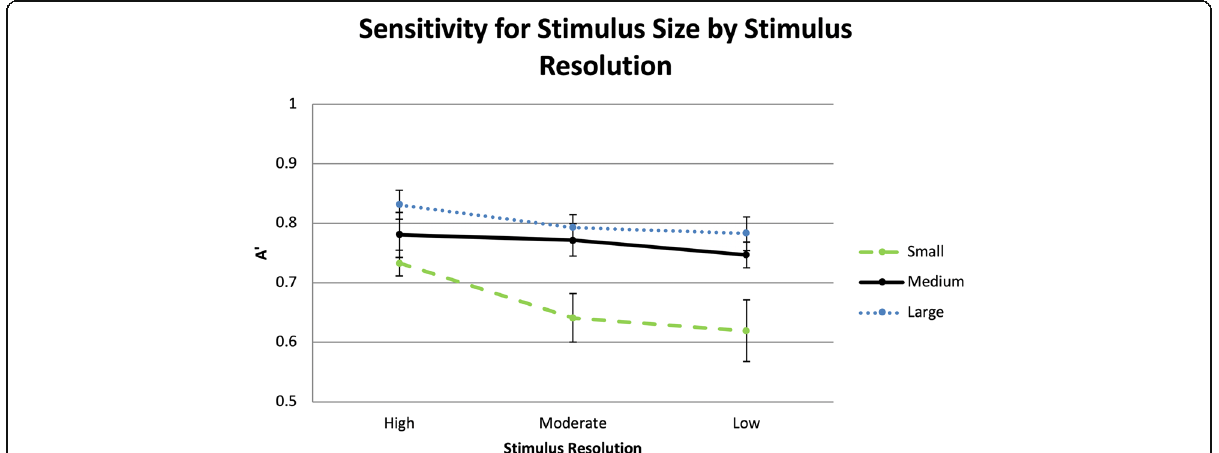
Fig. 12 Sensitivity as a function of image size and resolution. Error bars are within-subjects 95% confidence intervals (Cousineau, 2005; Morey, 2008).